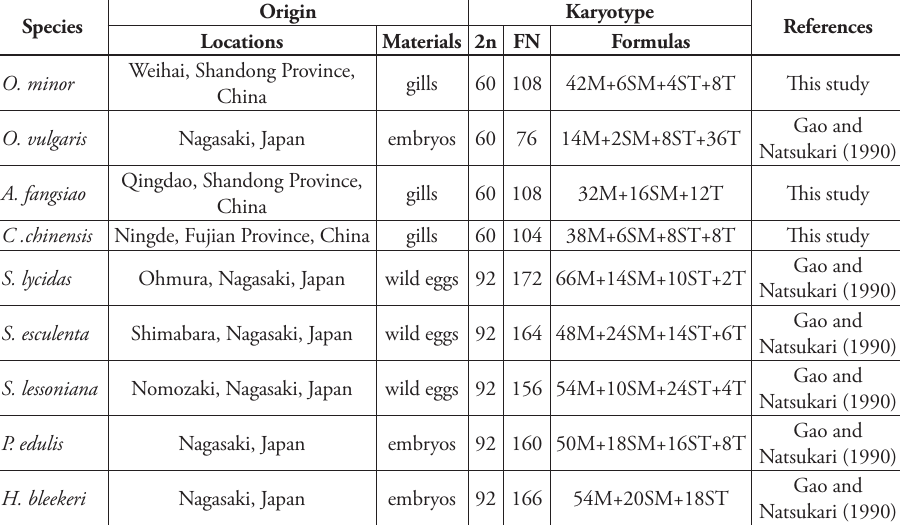
Table 1. Basic karyotype information of nine species of